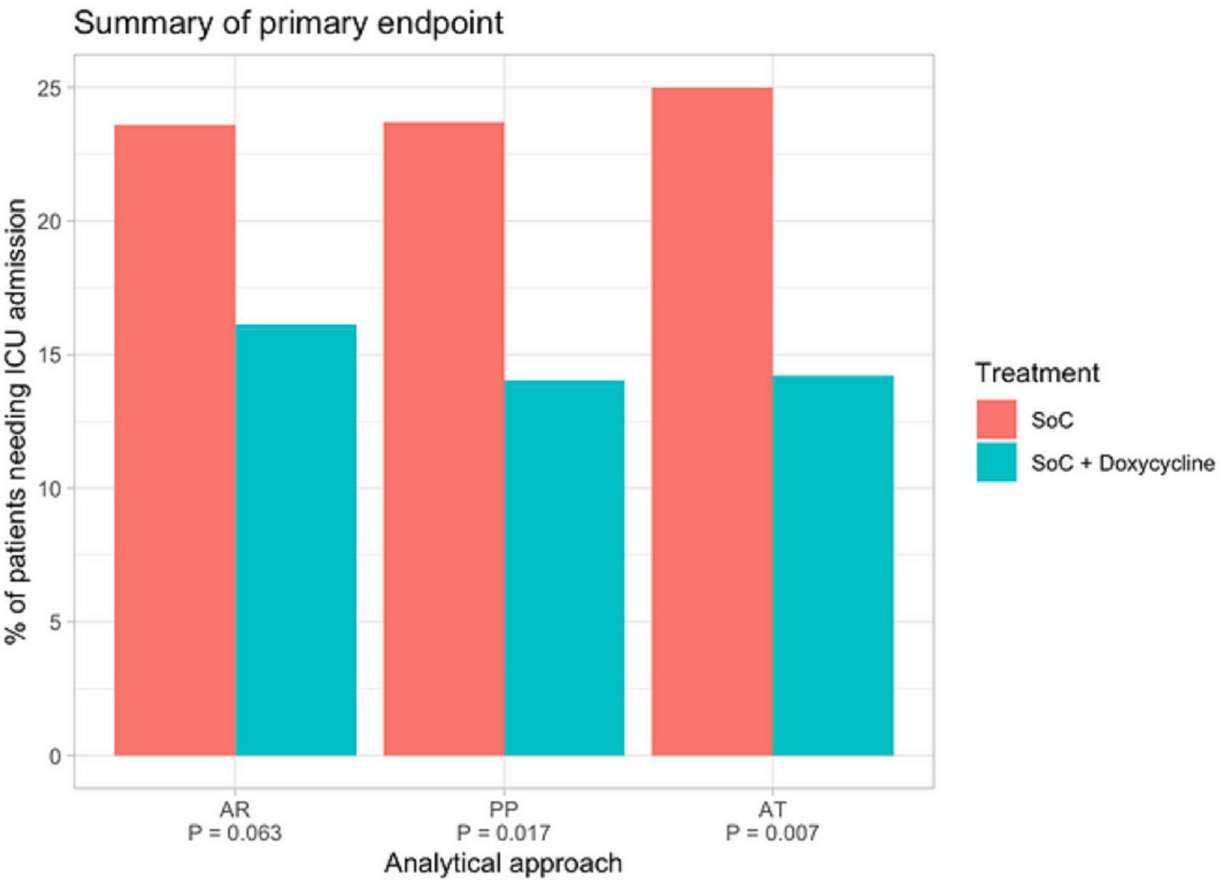
Fig 4. Summary of primary outcome data. Analyses of primary outcome data (need for ICU admission). ITT, as randomized; PP, per protocol; AT, as treated. Red bars: SoC; green bars: SoC+Doxy.